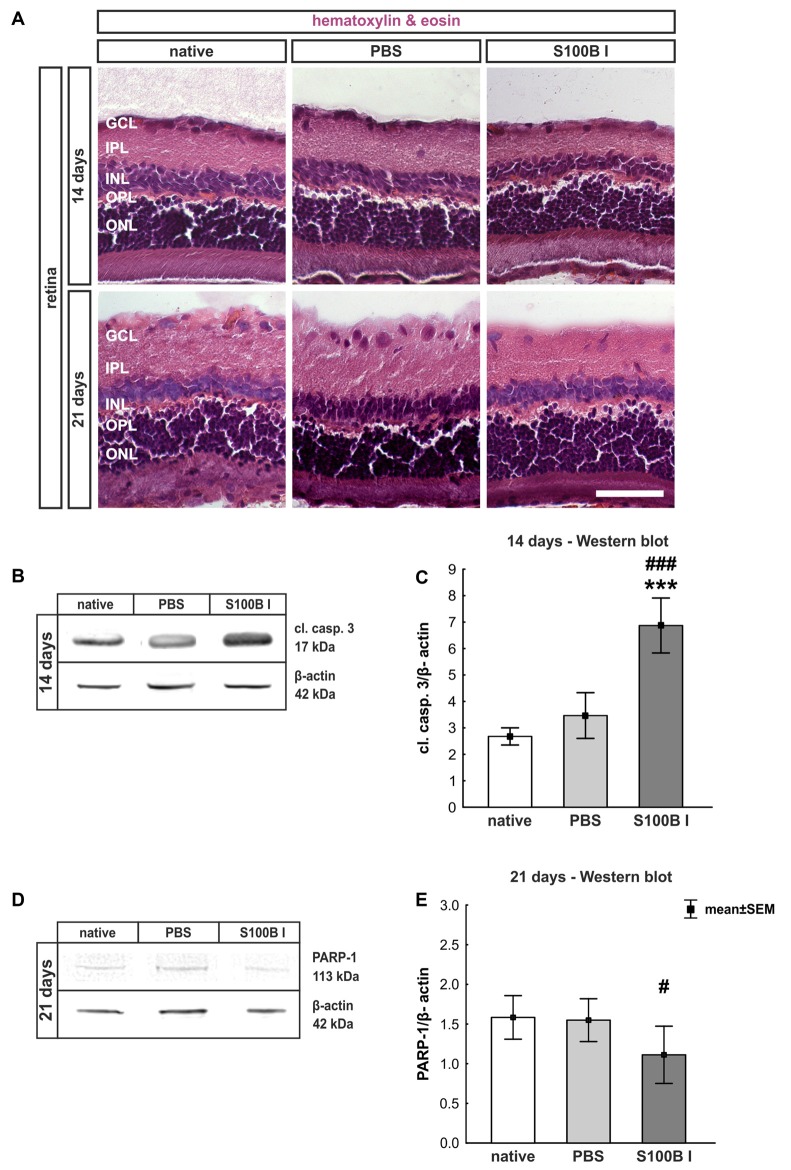
Intact retinal morphology, but peak of apoptosis at day 14. (A) Via hematoxylin and eosin staining, we could show that retinas still had an intact structure at 14 and 21 days in all groups. S100B I did not induce cellular infiltrations or damage to retinal layers. (B) Western blot analysis of cleaved caspase 3 (17 kDa) was normalized with β-actin (42 kDa) at 14 days. (C) At day 14, the protein level of cleaved caspase 3 was increased in the S100B I group compared to PBS and native group (both: p < 0.001). (D) At day 21, poly (ADP-ribose) polymerase 1 (PARP-1; 113 kDa) was analyzed via Western blot. (E) Here, differences between the S100B I and native group were observed (p = 0.027) and a decreasing trend in comparison to the PBS group (p = 0.06). GCL, ganglion cell layer; IPL, inner plexiform layer; INL, inner nuclear layer; OPL, outer plexiform layer; ONL, outer nuclear layer; scale bar = 50 μm; ***p < 0.001 (compared to PBS group); #p < 0.05, ###p < 0.001 (compared to native group).